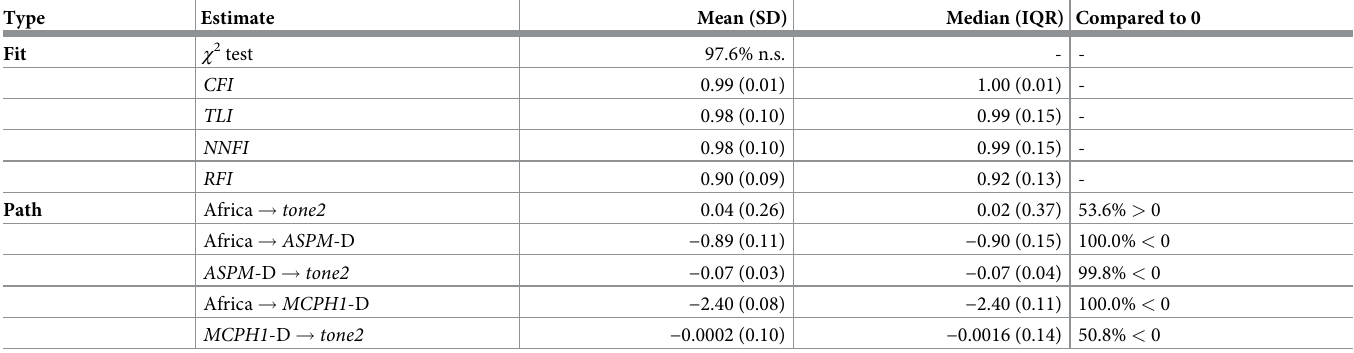
Table 12. Summaries of the path analysis for 1,000 restricted samples for tone2 . Similar conventions as for Table 9. Type Estimate Mean (SD) Median (IQR) Compared to 0 Fit 97.6%